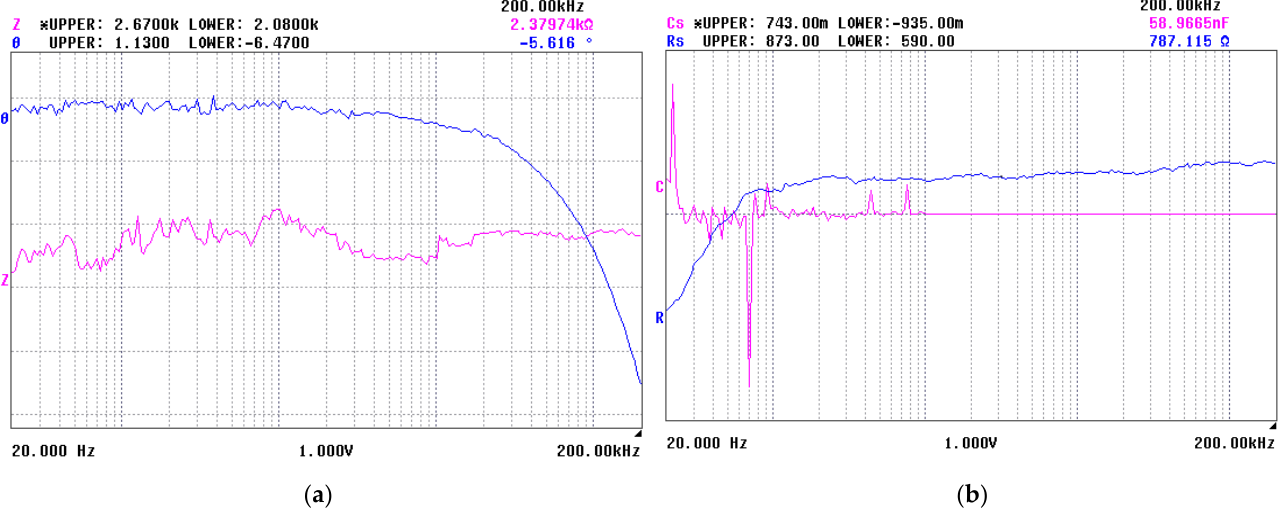
Figure 3. Bode plot ( a ) and frequency sweep of the contact parameters ( b ) of PVDF-TrFE/BST/PVDF- TrFE sample.